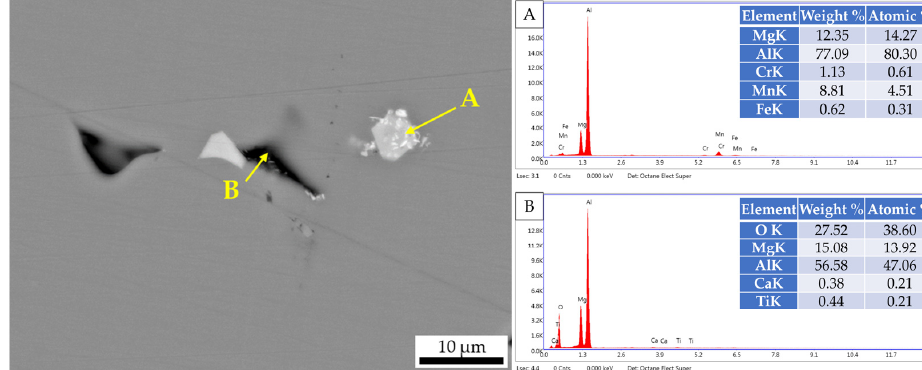
Figure 4. EDS result of inclusions in Al-6Mg alloy: ( A ) white inclusion, ( B ) black inclusion. In order to further obtain the total amount and size distribution of inclusions, Image- Pro Plus was used to statistically analyze the inclusions in Figure 3. Figure 5 shows the total inclusion content in the three purification processes. Figure 6 shows the inclusions’ size distribution of the Al-6Mg alloy under different conditions.